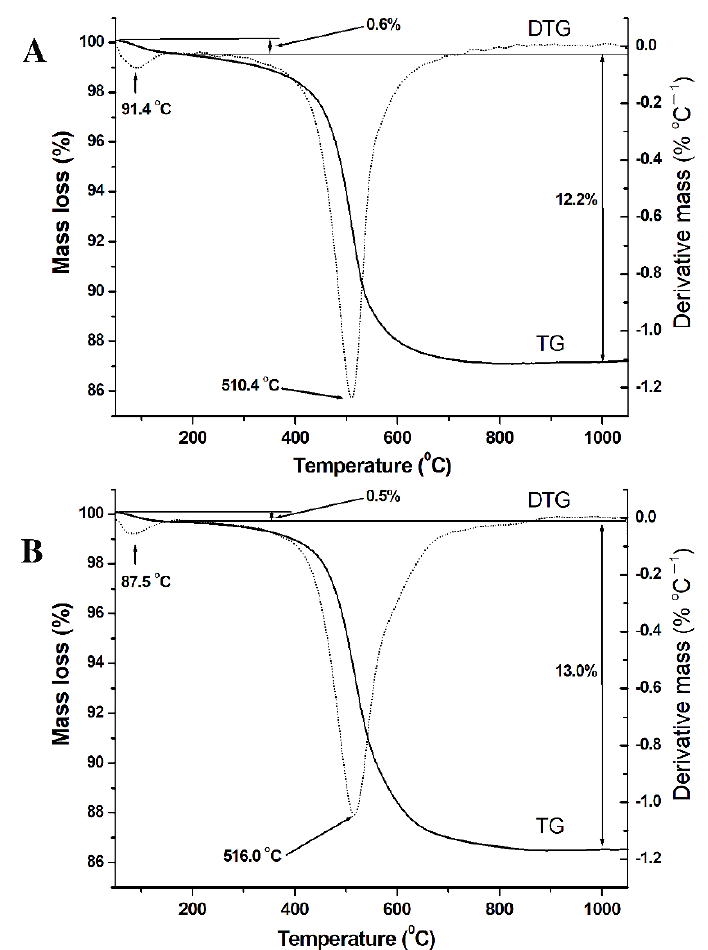
Figure 9. Thermogravimetry (TG) and derivative thermogravimetry (DTG) graphs of the UPS ( A ) and LOS ( B ) samples.